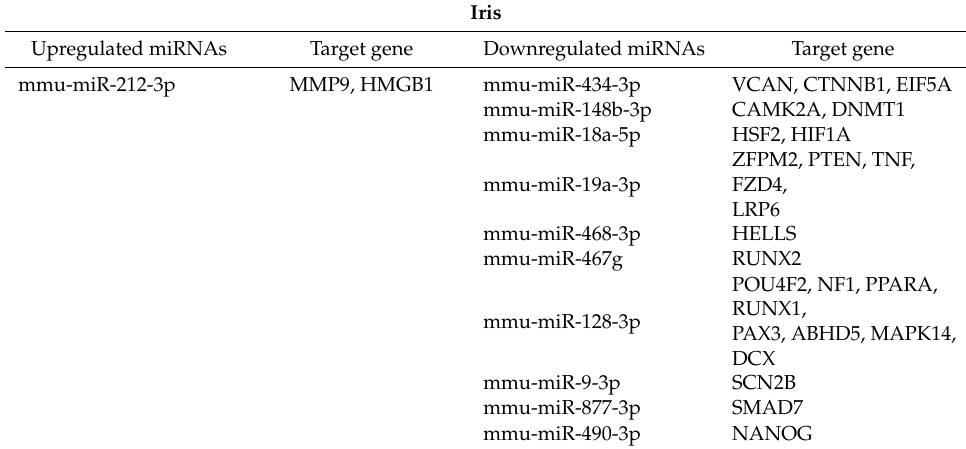
Table 9. The target genes predicted from the change in miRNA expression in the